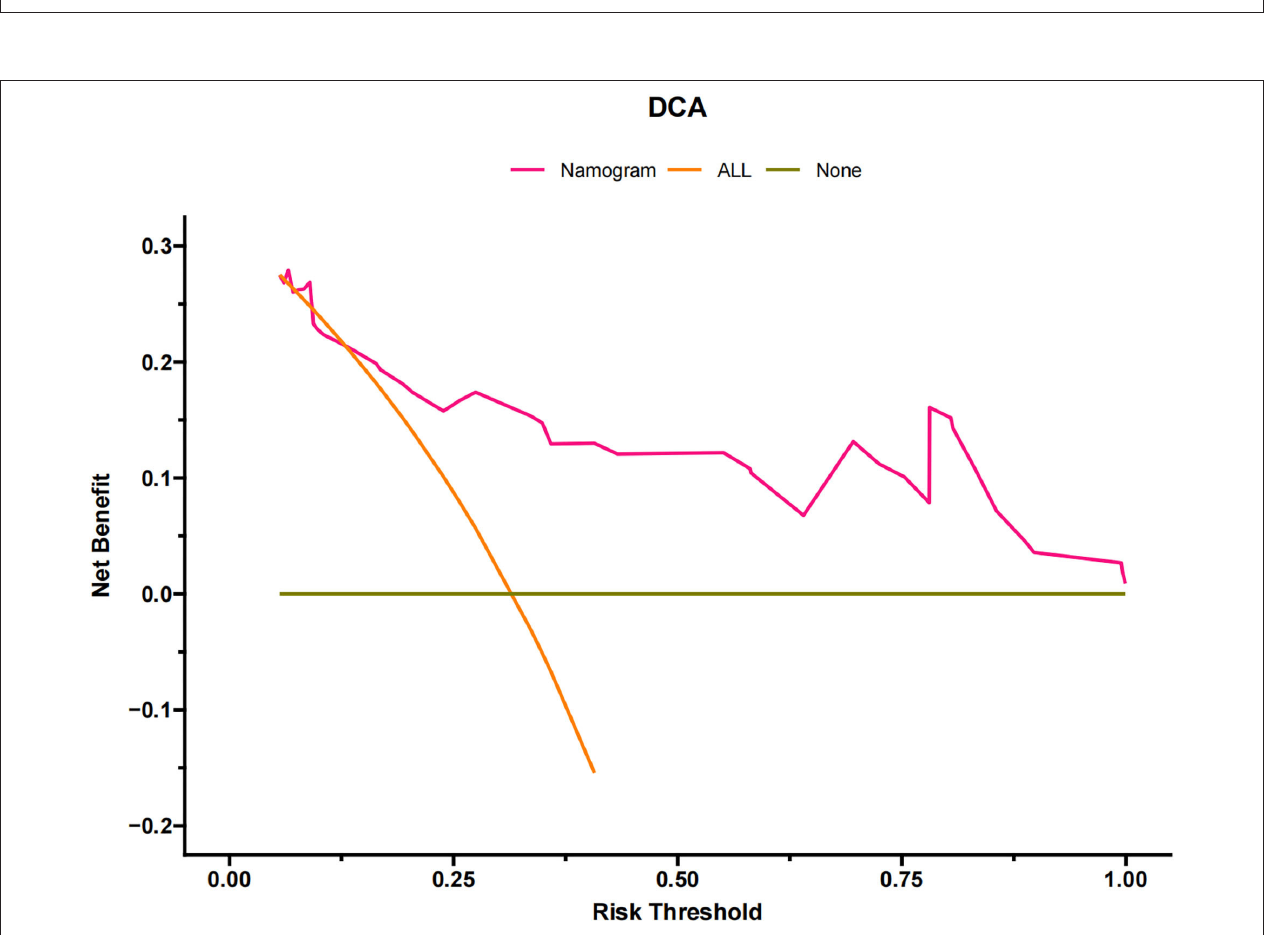
FIGURE 7 | Decision curves of the nomogram predicting CSS in CHCMU.